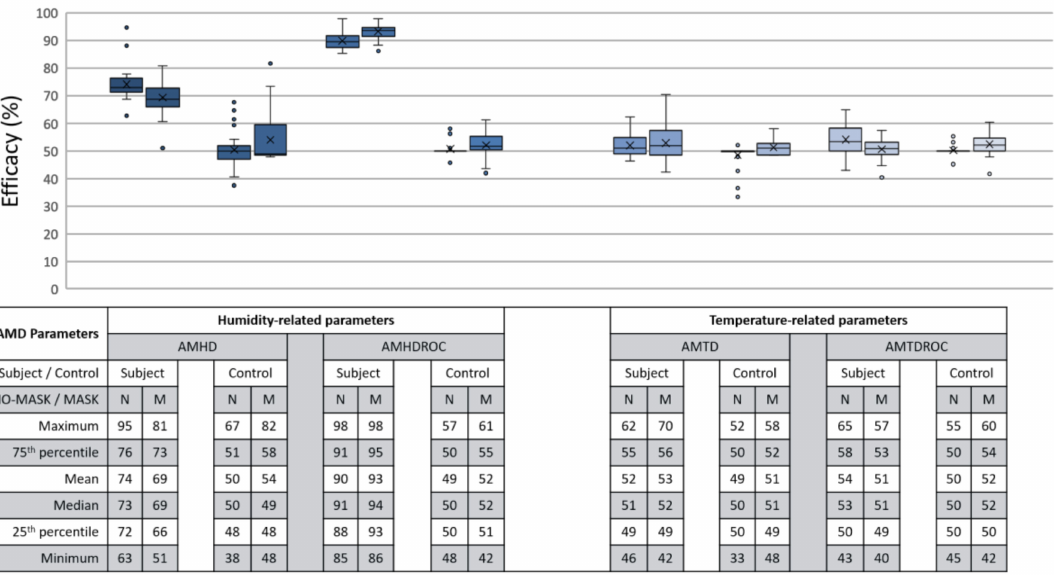
Figure 15. Efficacy between S and C groups during continuous monitoring. Each box contains 30 respective entries. AMHD (leftmost) has a mean of 74% under N condition and 69% under M